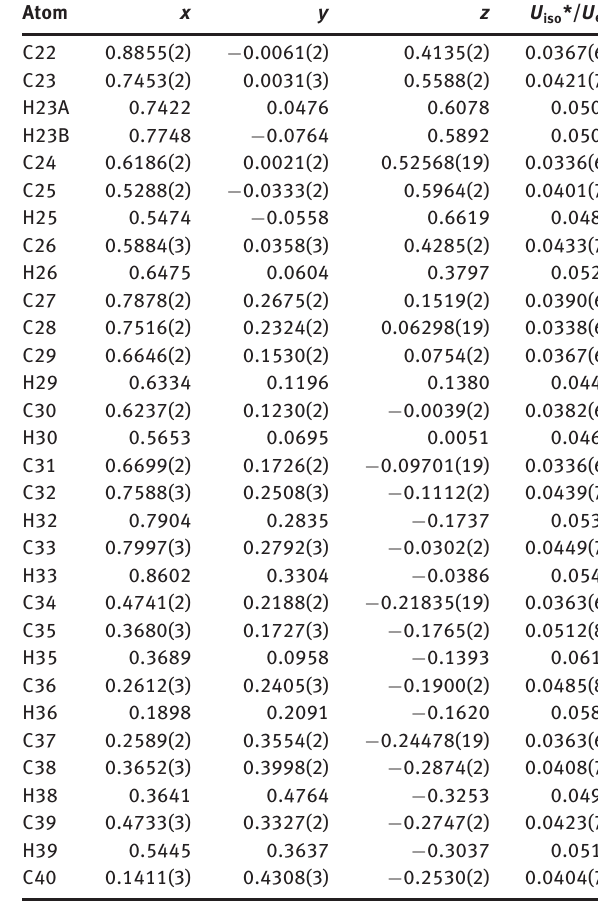
Table 2: Fractional atomic coordinates and isotropic or equivalent isotropic displacement parameters (Å 2